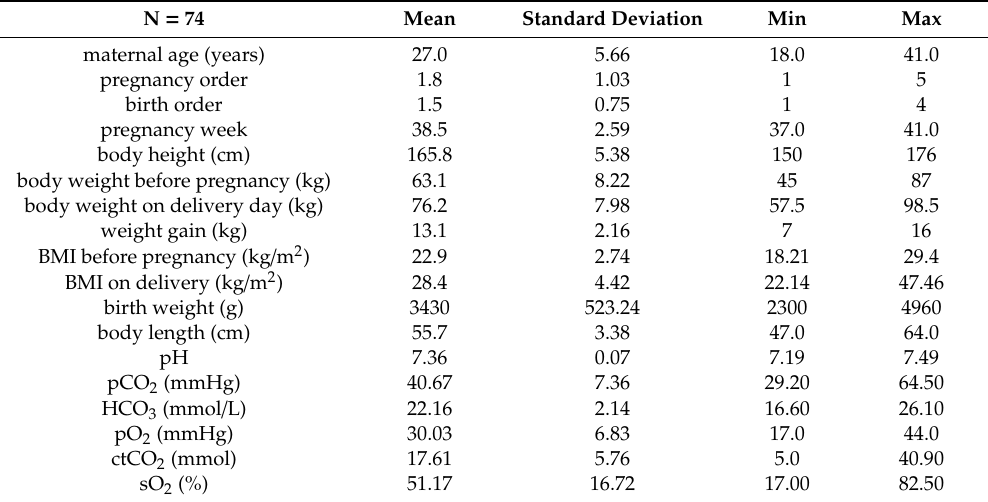
Table 1. Descriptive statistics of the values of maternal and neonatal traits under analysis.